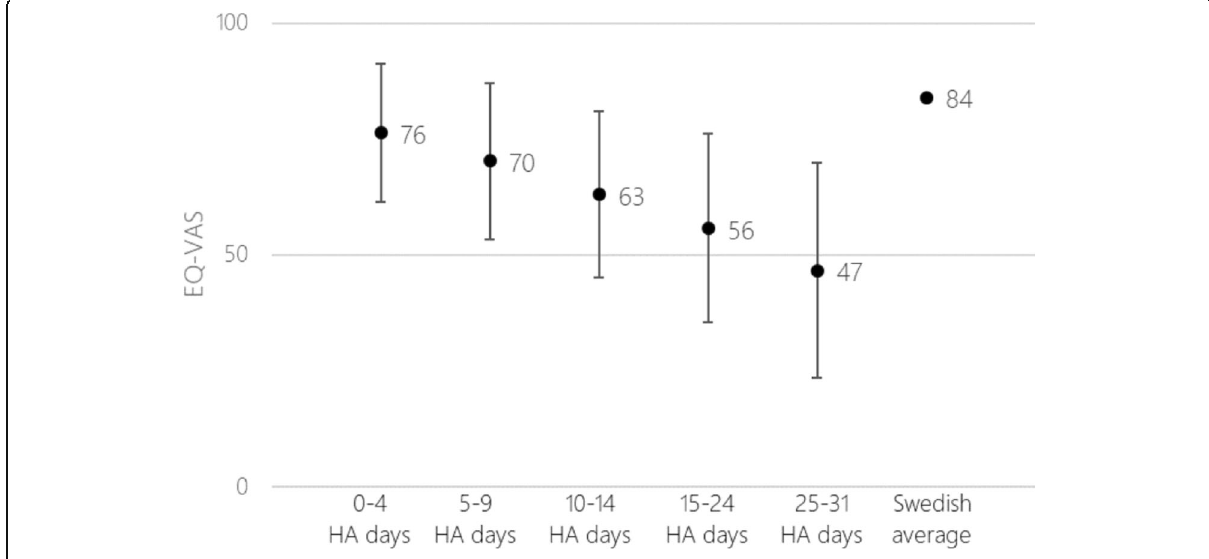
Fig. 2 Mean EQ-VAS by number of headache days per month. Key: HA, headache